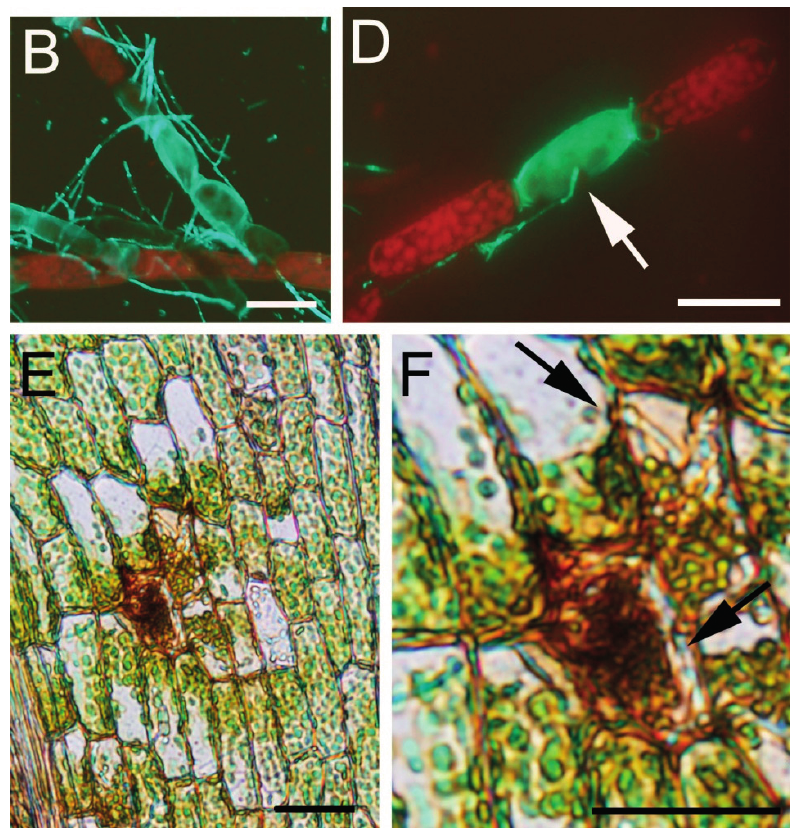
Figure 4. Cytoplasmic shrinkage and intracellular relocation of chloroplasts after C. gloeo-sporioides infection. ( A , C ) Protonemal tissues inoculated with C. gloeosporioides ; ( B , D ) Protonemal tissues inoculated with C. gloeosporioides and stained with solophenyl; ( E ) C. gloeosporioides infected leaf showing chloroplast relocation ( F ) Closer view of E , hyphae are indicated with black arrows. Arrows in C and D indicate a hypha in contact with a protonemal cell. Scale bars represent 20 μ m in A – D and 50 μ m in E – F